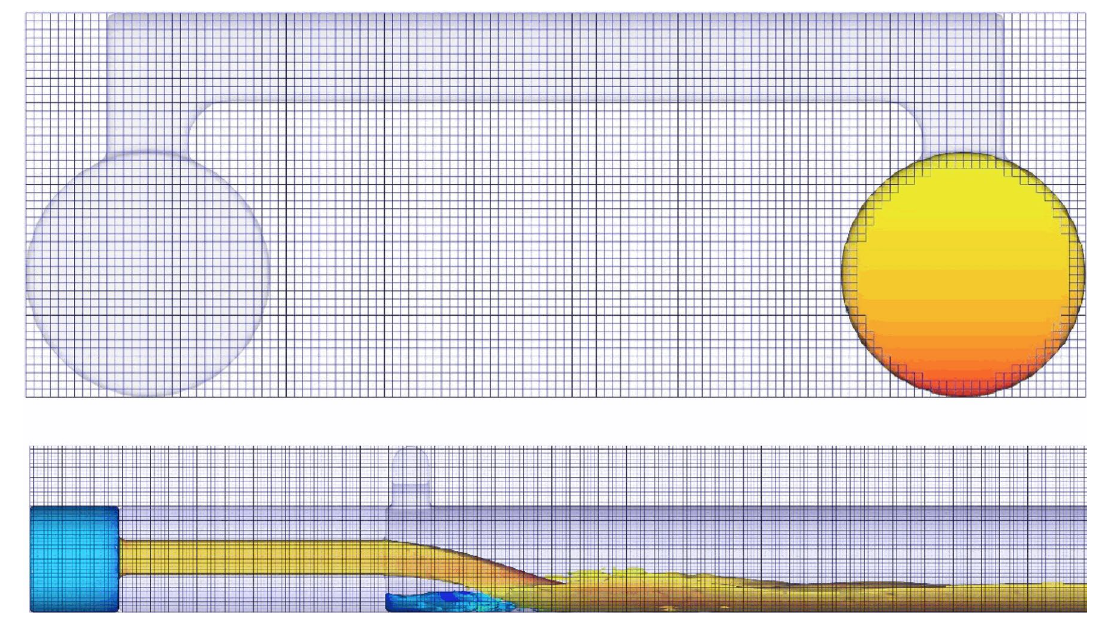
Fig. 3 Mesh structures of the numerical model